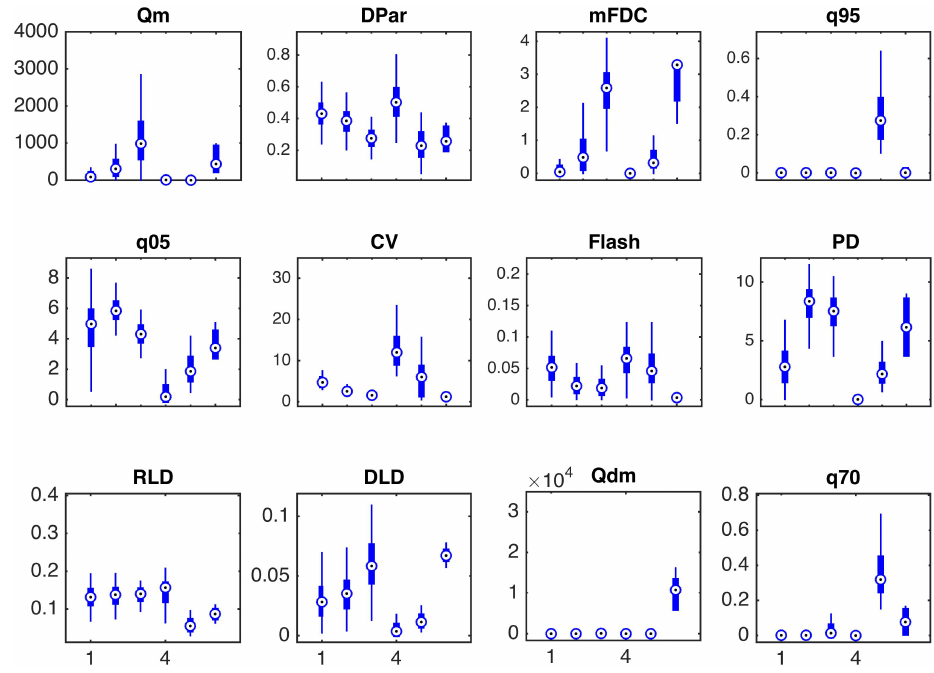
Figure 14. Distribution of signature values for each cluster (at the regional step). The flow signatures are described in Appendix A.